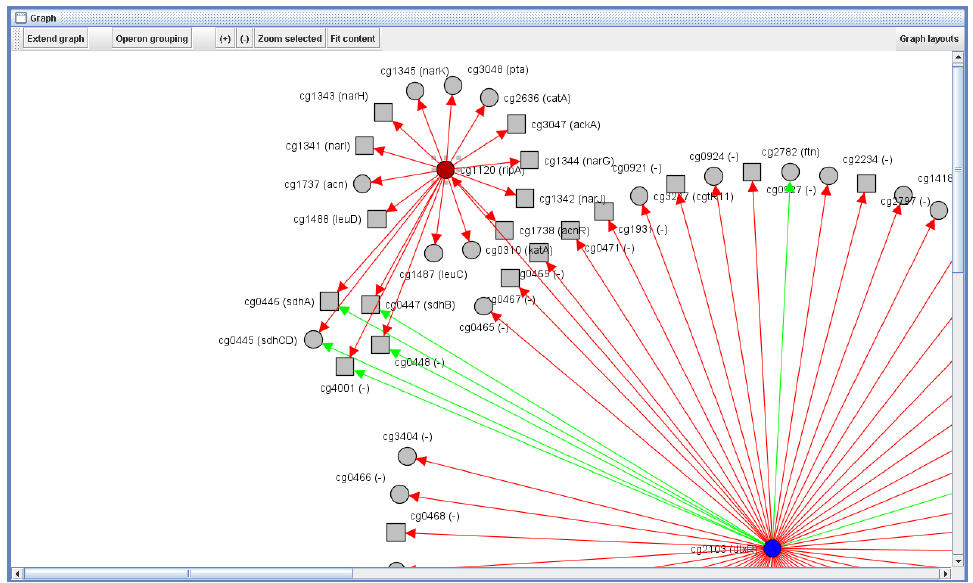
Figure 5: Dynamic extension of the regulatory network of DtxR of C. glutamicum . The graph is extended at cg1120 encoding transcription factor RipA. The sub-regulatory network of this repressor (red nodes and red lines) is visualized including genes co-regulated by DtxR (blue node) and